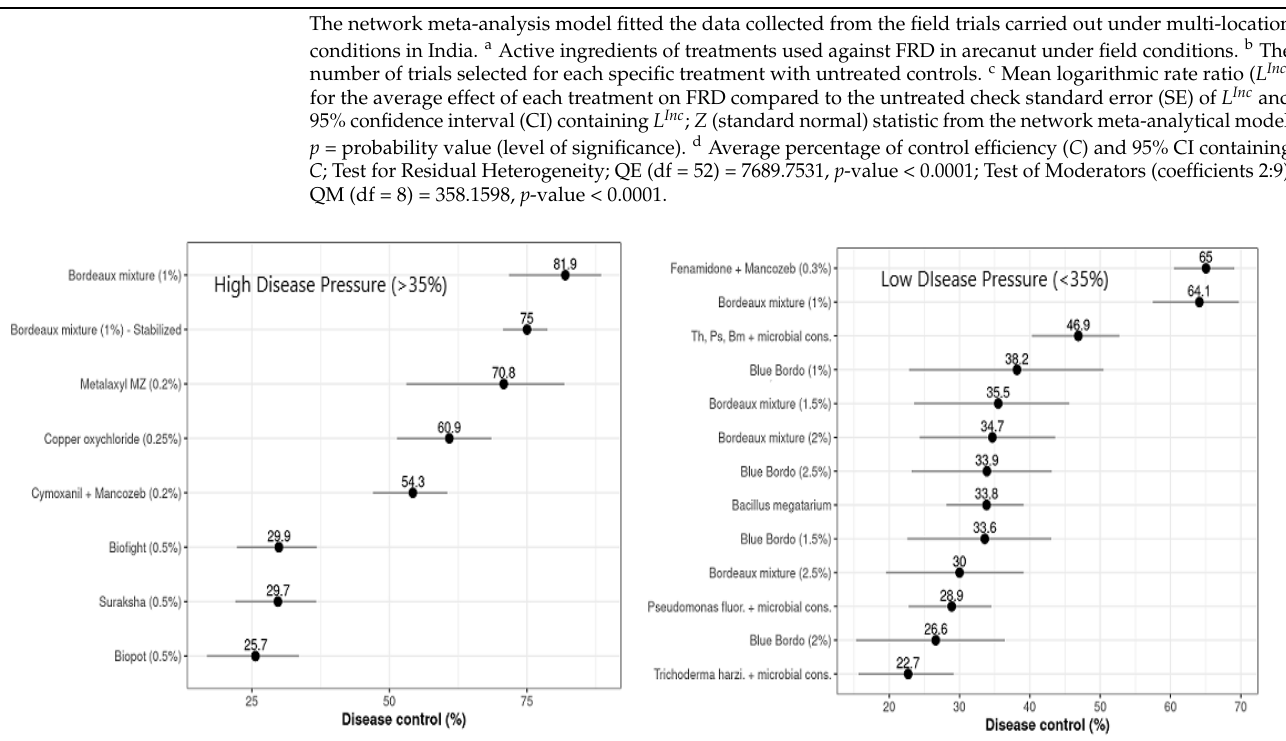
Figure 4. Overall mean control efficiency (%) of evaluated treatments against FRD was estimated by multivariate meta-analysis. Horizontal bars represent 95% confidence intervals; points indicate the differences in control efficiency.